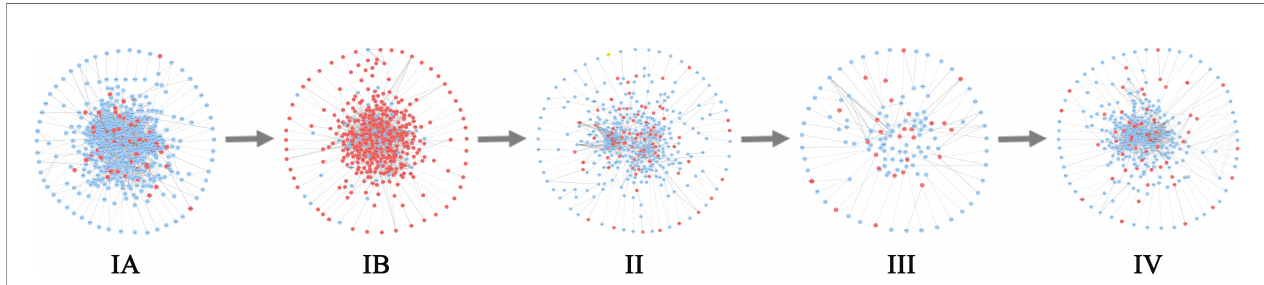
FIGURE 10 | The dynamic evolution of the sJSD signal biomarkers for PAAD. It can be seen there is a signi fi cant change in the internal structure of sJSD signal biomarkers at